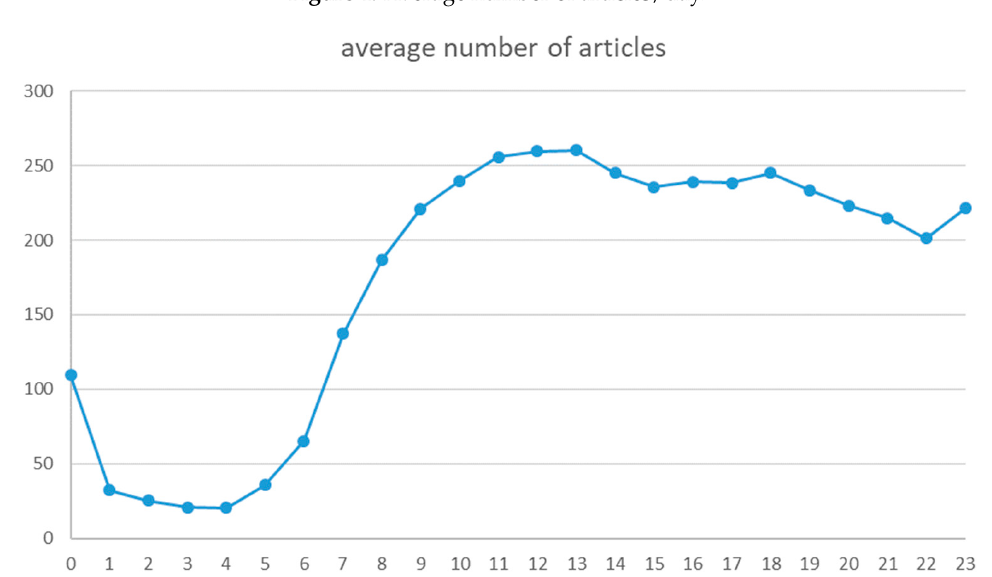
Figure 5. Average number of articles/hours of day.